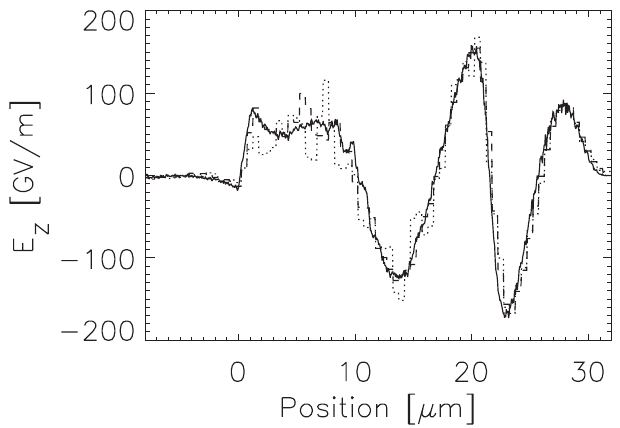
FIG. 5. Longitudinal electric field in the wake of a laser pulse, computed with full PIC (solid), as compared with the envelope model on a 100 times smaller grid and 10 times fewer particles (dashed) and with 100 times fewer particles (dotted). The plasma extends from x (cid:3) 0 to 32 (cid:3) m , with a linear density ramp in the first 20 (cid:3) m .